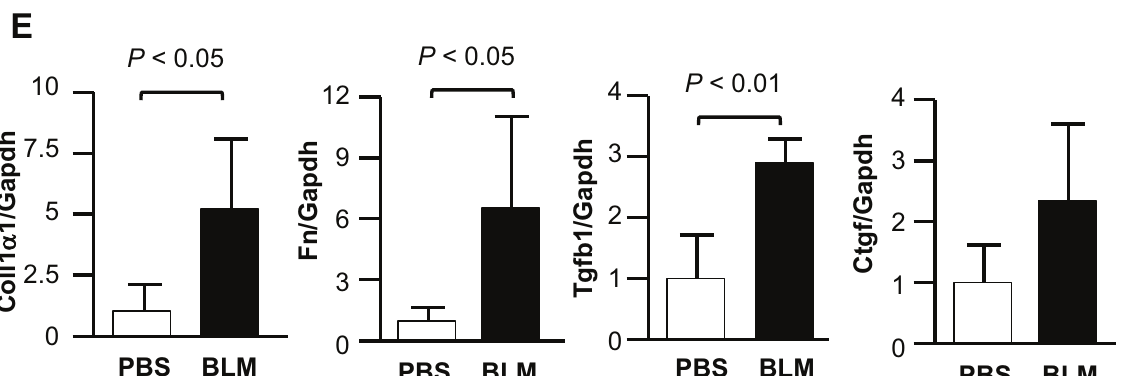
Fig 5. BLM-induced fibrosis in human skin ex vivo . Human skin from three different donors was injectedwith, or immersed in, media containing BLM (1 or 10 mU/ml) and maintained in culture for one week. (A) The amount of collagenin skin injectedwith